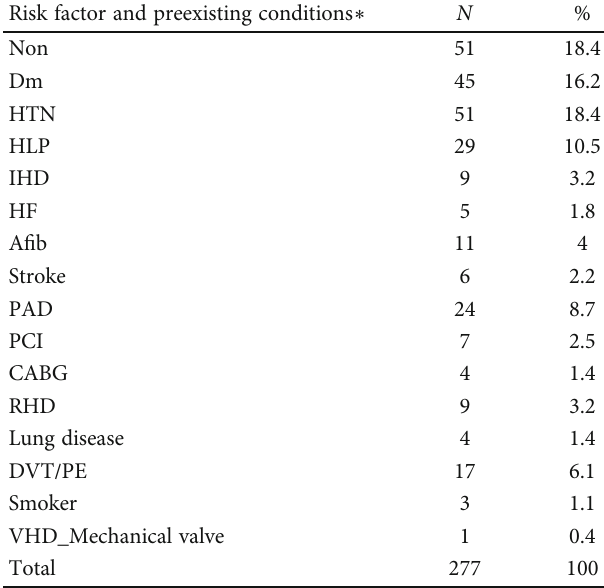
Table 2: Cardiac risk factors and preexisting